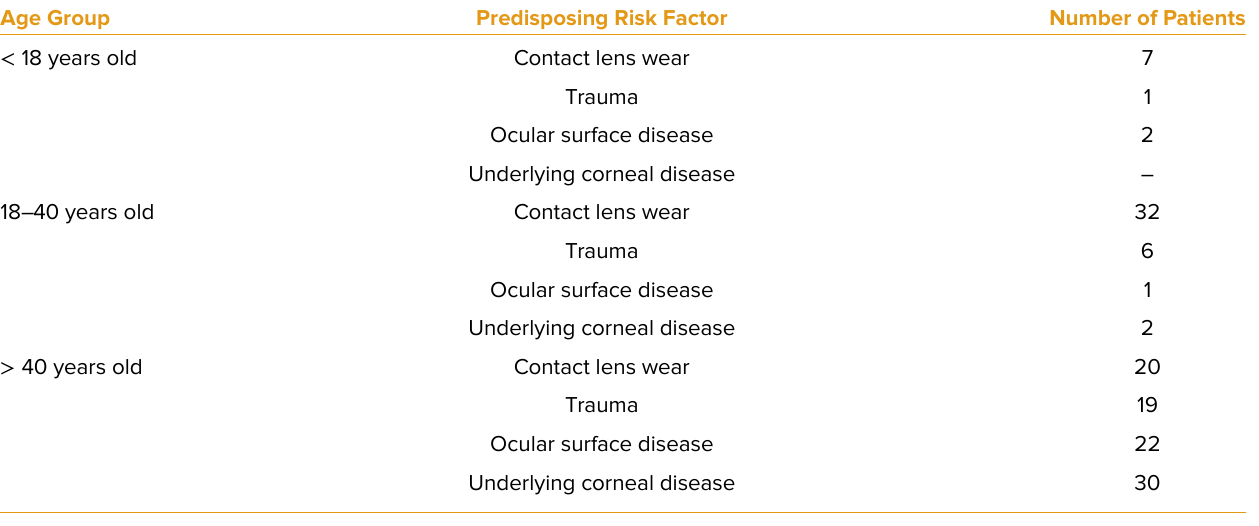
Table 5. Rate of infectious keratitis in South Texas compared with other locations %